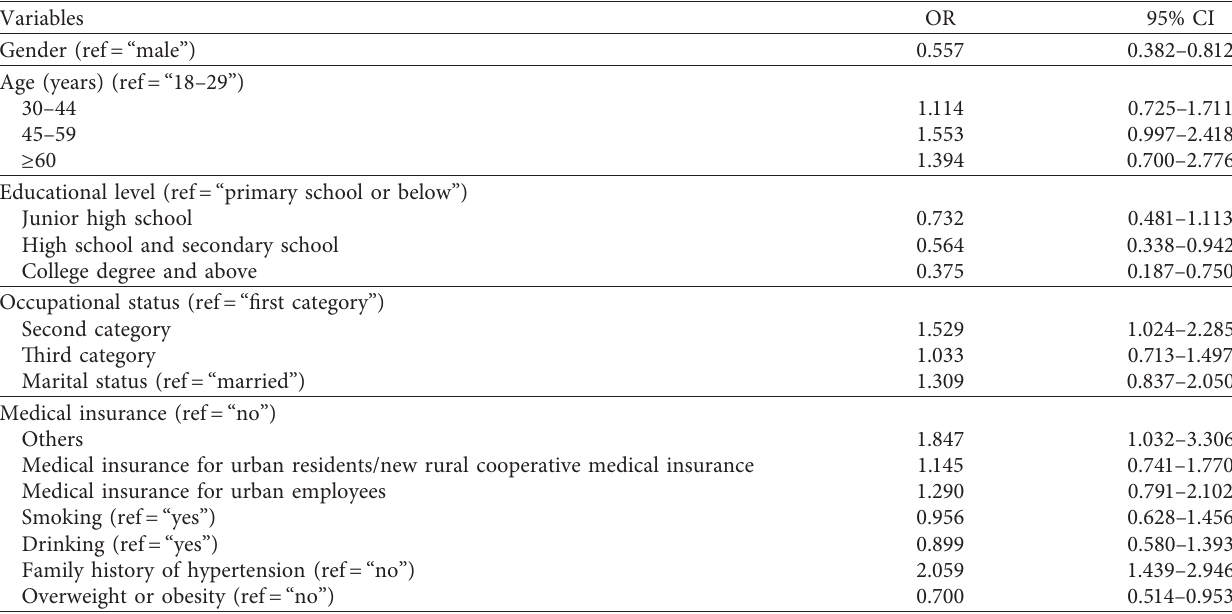
Table 4: Multivariable analysis of association between overweight/obesity and hypertension.